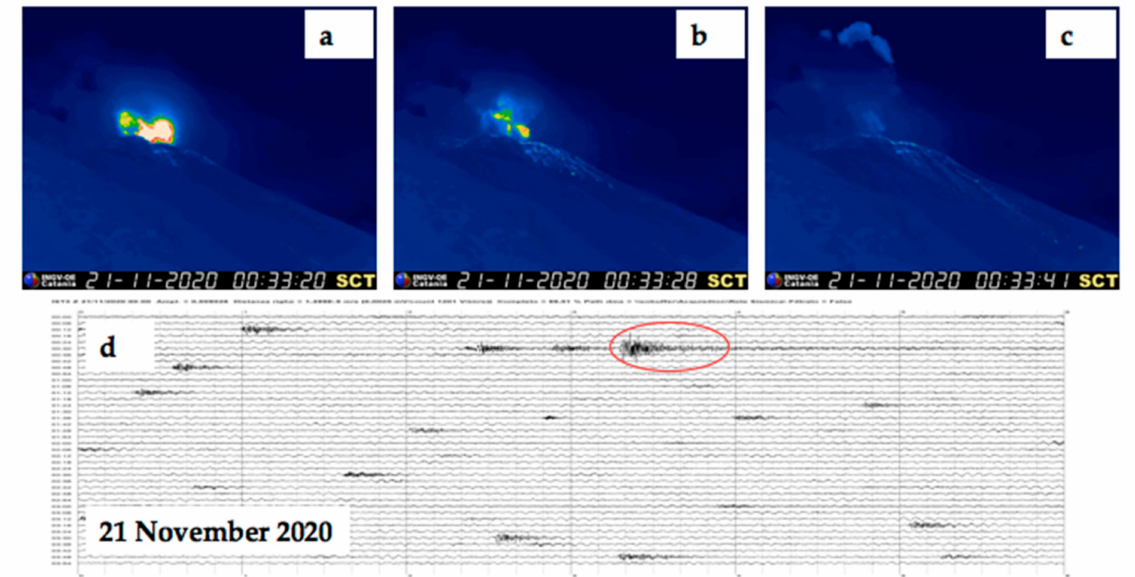
Figure 13. ( a – c ) Thermal images from the SCT camera of the 21 November 2020 event view from NE (blue is cold, white is hot), recorded at 00:33:20 ( a ), 00:33:28 ( b ), 00:33:41 ( c ) with ( d ) the corresponding seismic trace highlighted by the red oval. See Figure 1 for station